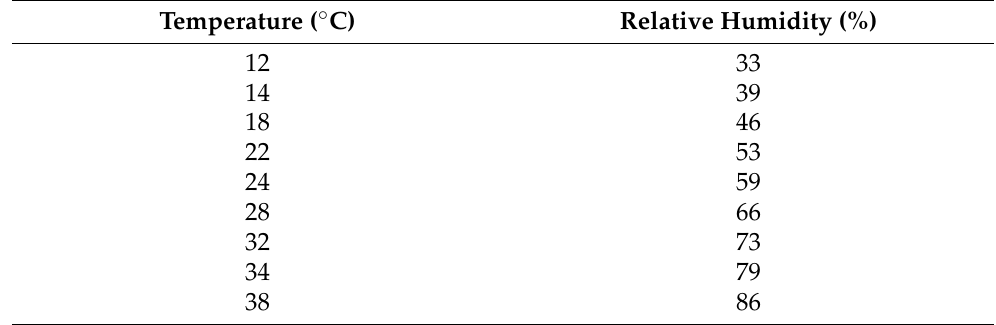
Table 4. Temperature and relative humidity setpoints used to create the validation dataset. Nine temperature setpoints and nine relative humidity setpoints resulted in 81 setpoint